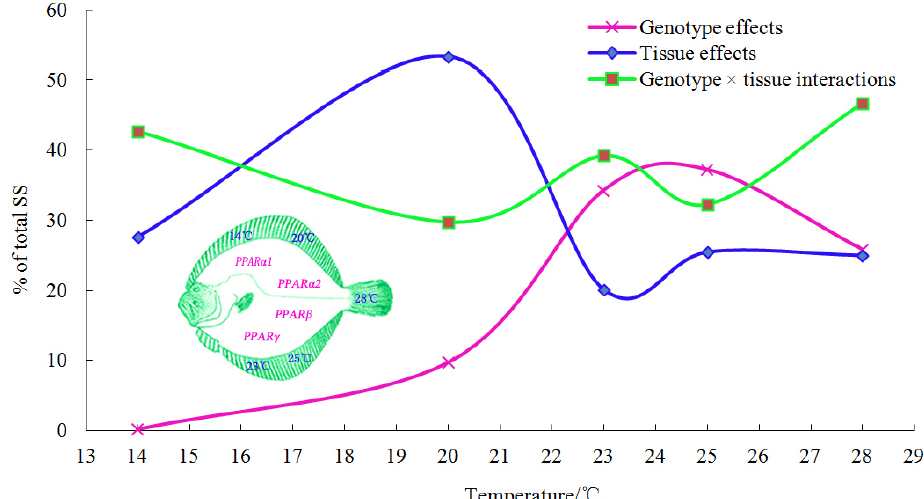
Figure 2. Genotype effect, tissue effect, and genotype × tissue interaction changes with temperature.